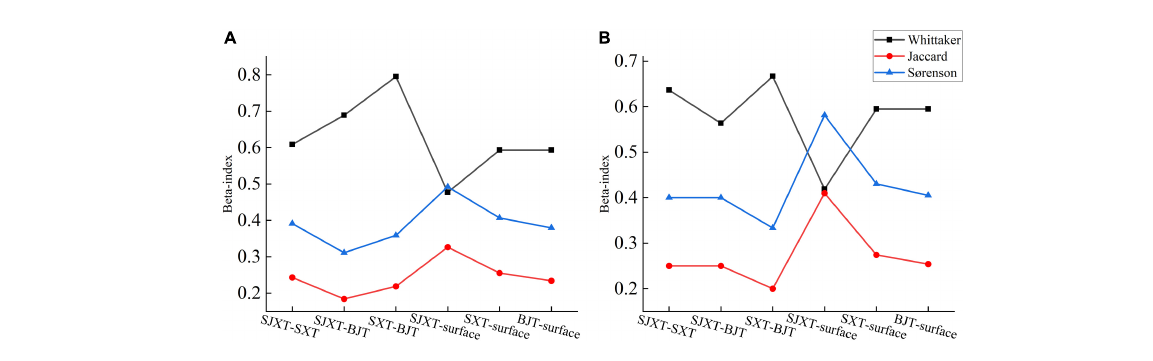
FIGURE4 Similarity coefficient comparison within and outside the degraded karst tiankeng. (A) Tree, (B) shrub.